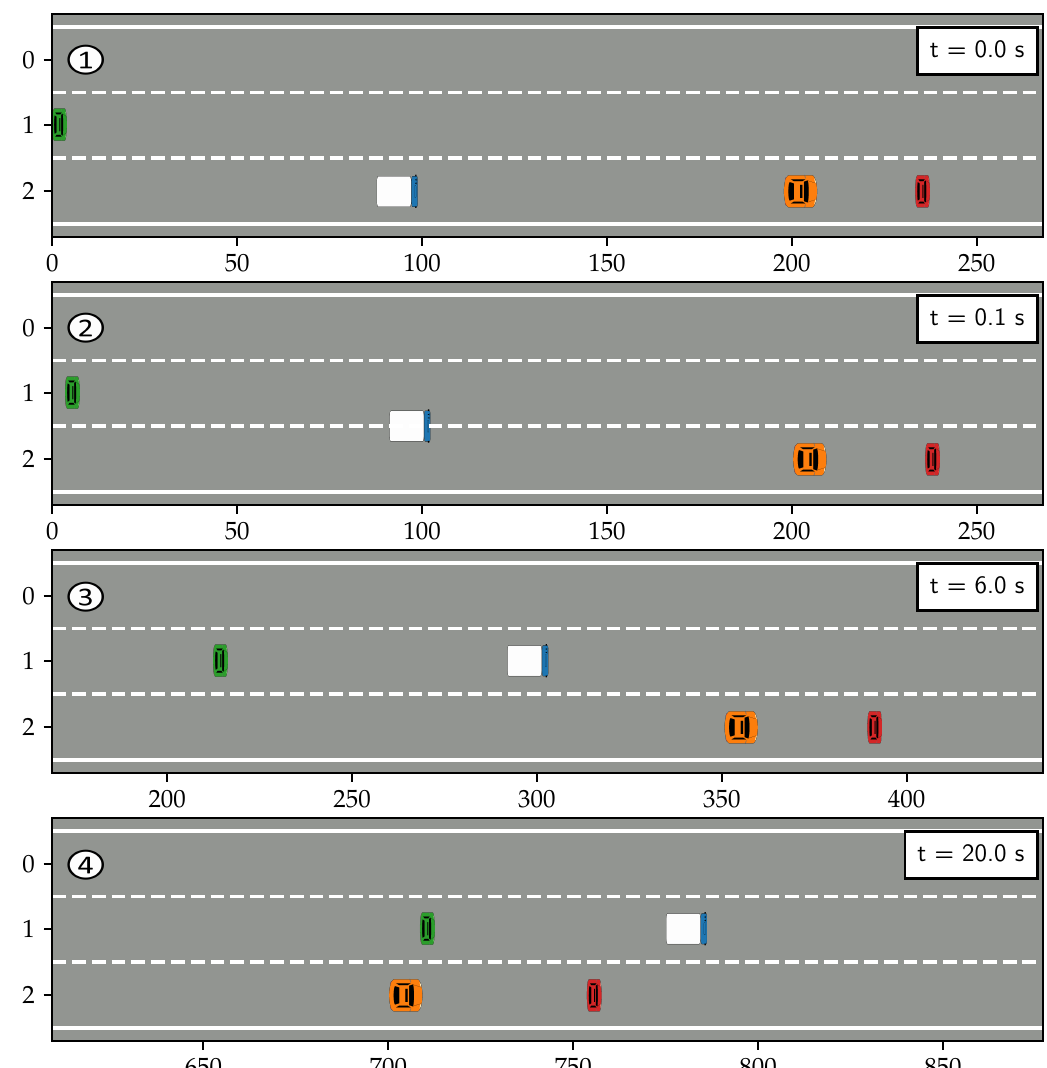
Figure 4. Longitudinal plot of the simple planner.